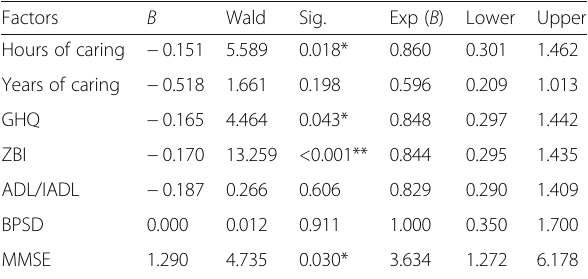
Table 5 Logistic regression for predictive factors of dementia caregivers ’ psychiatric morbidity